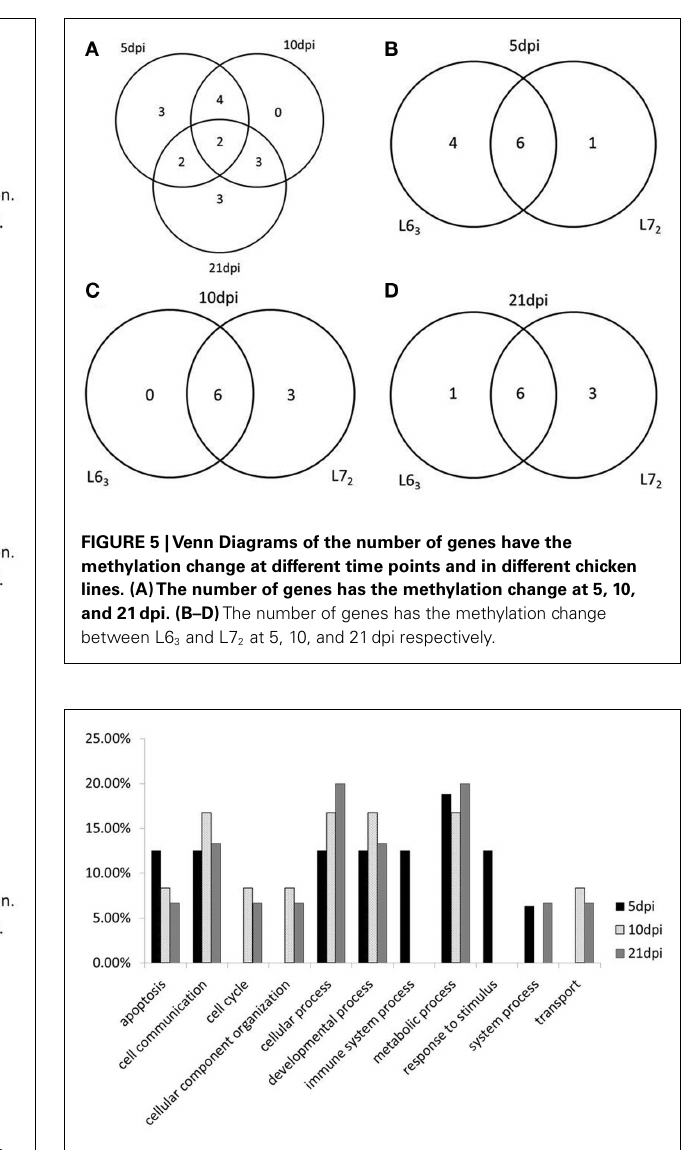
FIGURE 6 | Functional analysis of the genes have different methylation change between L6 3 and L7 2 at 5, 10, and 21dpi by